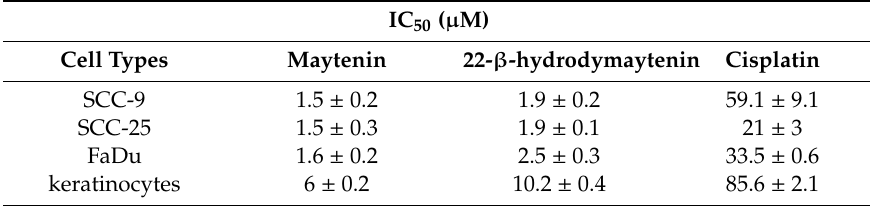
Table 1. IC 50 following 24 h incubation for maytenin, 22- β -hydrodymaytenin and cisplatin as determined by MTT